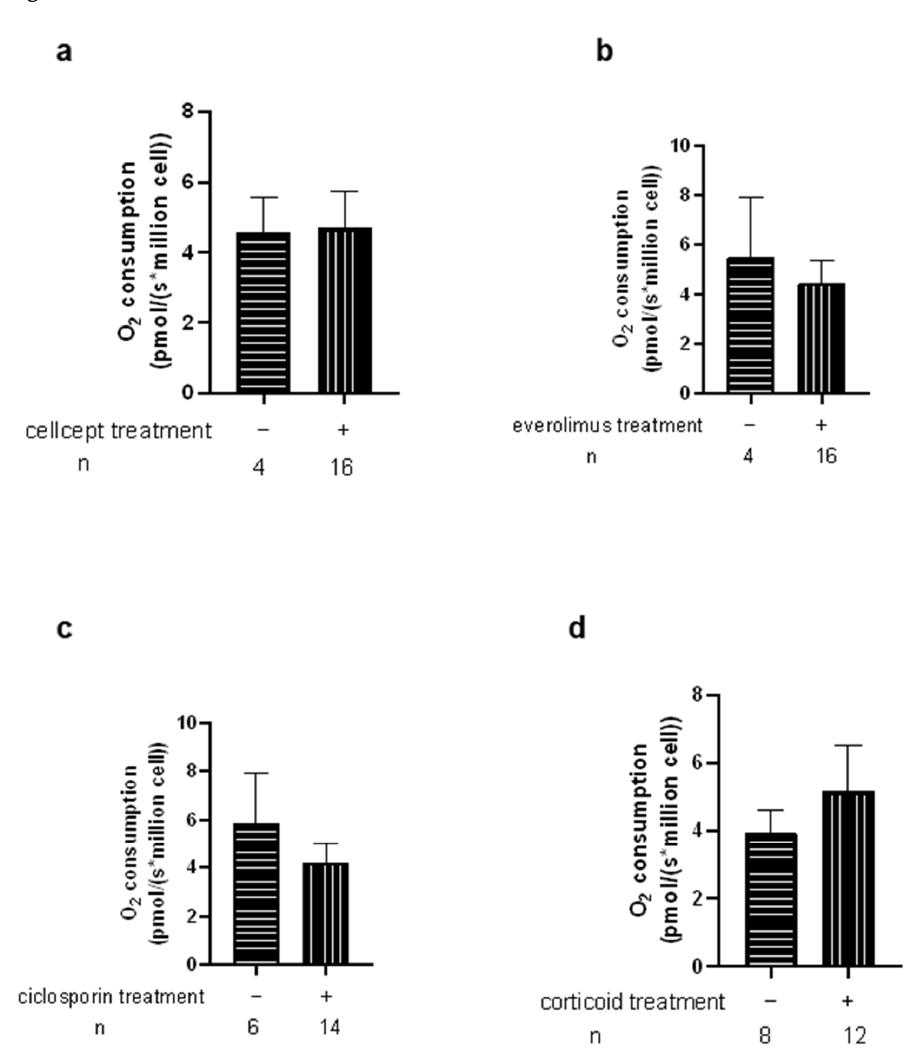
Figure 7. Effects of immunosuppressive therapies on transplant patients PBMCs mitochondrial respiration by complex II (OXPHOS CII). − /+ represents the group without or with specific treatment. n: number of patients in each group. Values are means ± SEM ( a ) Cellcept. ( b ) Everolimus ( c ) Ciclosporin ( d ) Corticoid.